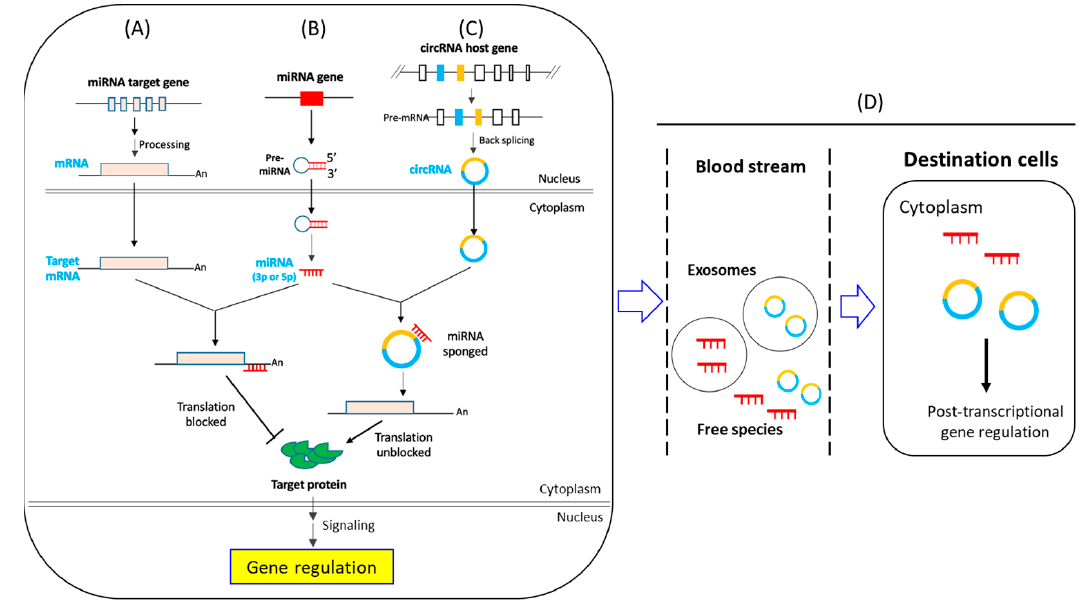
Figure 1. The circRNA- and miRNA-mediated post-transcriptional regulation of gene expression: an overview. ( A – C ) Basic mechanisms of biogenesis of mRNA ( A ), miRNA ( B ) and circRNA ( C ), and interactions between the various RNA species. Notably, the transcript of a miRNA gene first forms a precursor pre-miRNA, which matures into single-stranded 5p and/or 3p miRNA species to bind to the 3 ′ -UTR of the targeted mRNA to induce mRNA degradation or to block translation. A mature circRNA, formed via backsplicing of the pre-mRNA of a host gene, sponges to deplete the targeted miRNA, unblocking mRNA translation by the miRNA. ( D ) CircRNA and miRNA may also be re- leased into the blood stream encapsulated in exosomes, or as free forms, to reach a distant destina- tion cell to exert their post-transcriptional regulatory functions.